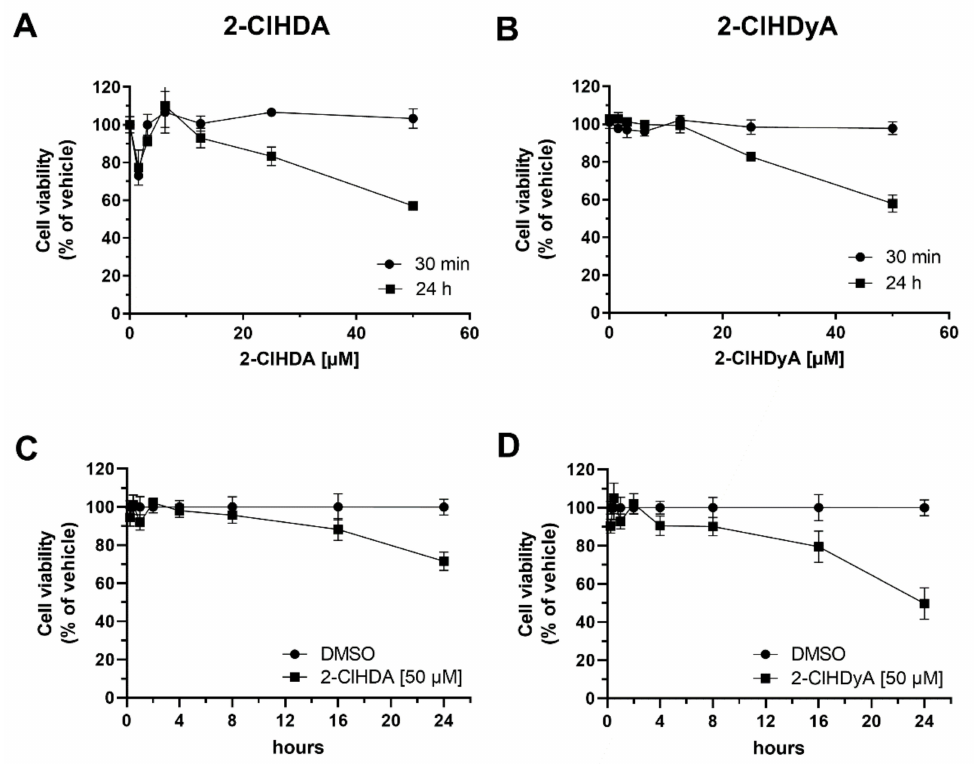
Figure 4. E ff ects of 2-ClHDA and 2-ClHDyA on cell viability. Viability of HL-1 cells was assessed with the CellTiter-Glo 3D kit detecting ATP as an indicator of cell viability. Cells were treated with ( A ) 2-ClHDA or ( B ) 2-ClHDyA at indicated concentrations for 30 min and 24 h. The time-dependent e ff ect of 50 µ M 2-ClHDA and 2-ClHDyA on cell viability is shown in ( C ) and ( D ), respectively. DMSO was used as vehicle control. Data represent mean ± SD values ( n =